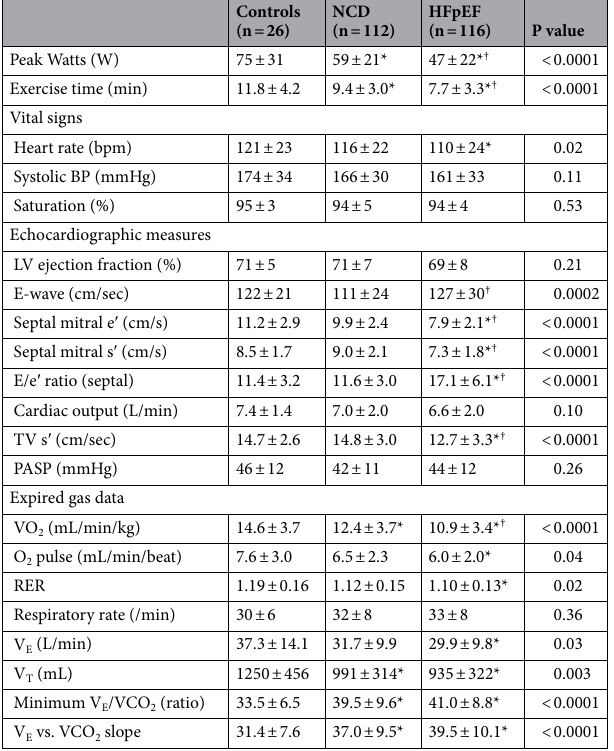
Table 3. Echocardiographic measures and expired gas data during peak exercise. Data are mean ± SD or median (interquartile range). Final column reflects overall group differences. *p < 0.05 vs. Controls; † p < 0.05 vs. NCD. RER, respiratory exchange ratio; VCO 2 , carbon dioxide volume; and other abbreviations as in Tables 1 and 2.